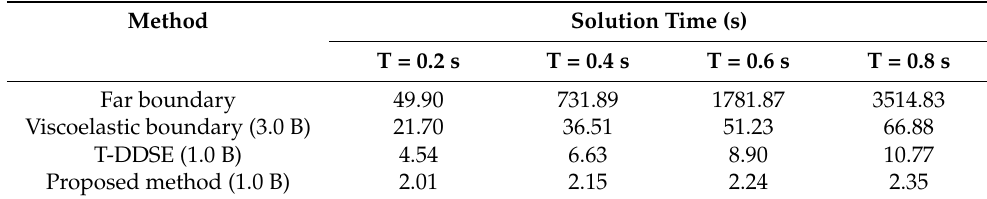
Table 2. Comparison of solution time of the far-field zone simulated by different methods.